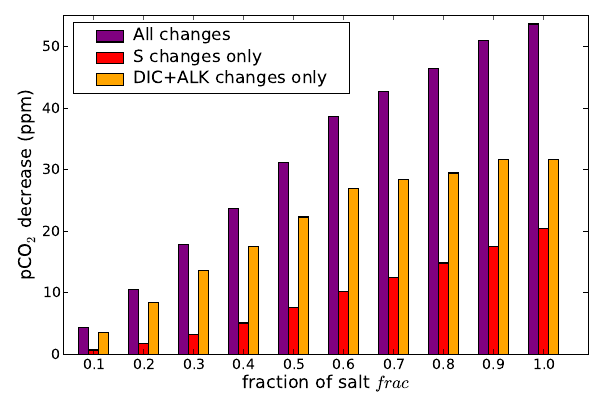
Fig. 5. Mean global ocean surface pCO 2 decrease due to the brine mechanism as a function of the fraction of salt rejected by sea ice formation used for the brine mechanism (fraction of salt frac , 0 ≤ frac ≤ 1 ). The pCO 2 is calculated from the chemical formulas of the surface ocean where the geochemical fields (salinity, temperature, DIC and ALK) are imposed and taken from the simulations with CLIMBER-2. In the pCO 2 calculations (except “All changes”) all the geochemical fields are from the standard LGM run (LGM-std, frac =0) except for one variable. Hence the “S changes only” (red) is the pCO 2 change due to the contribution of the modification in the salinity (S) distribution only (the distribution of the other variables is the one from the standard simulation). Similarly, the “DIC + ALK changes only” (orange) corresponds to the contribution of the modification of dissolved inorganic carbon (DIC) and alkalinity (ALK) only. However, “All Changes” (purple) corresponds to the decrease due to the change of distribution of all oceanic variables.